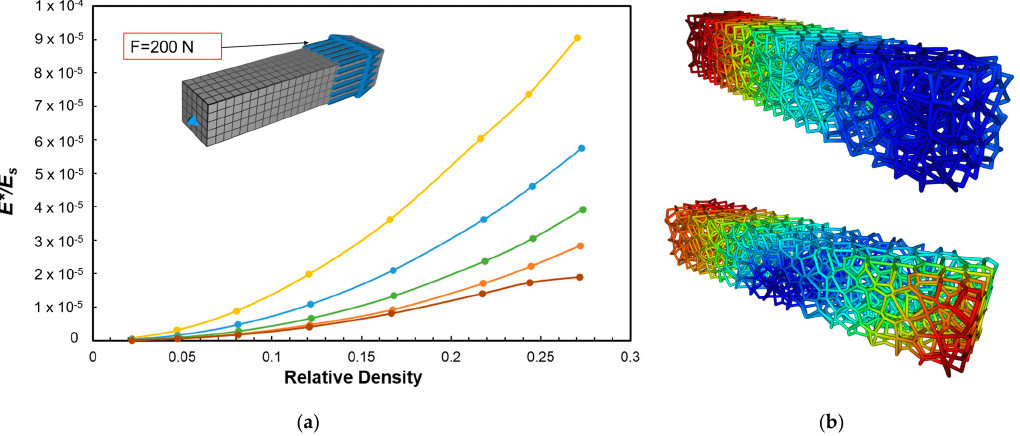
Figure 18. Effect of different Voronoi seeds on the ( a ) effective tensile modulus of stochastic lattice- filled beams and ( b ) axial displacement color contours.